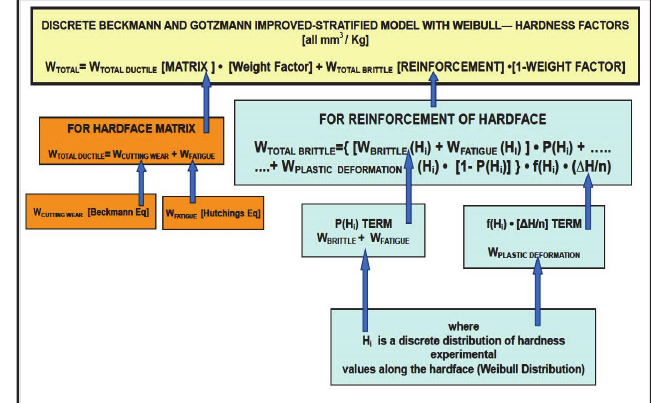
Fig. 14. Mathematical construction of a stratified discrete model based on successive applications of Beckmann and Gotzmann Equations [ Casesnoves, Kulu, Suzhenkov,